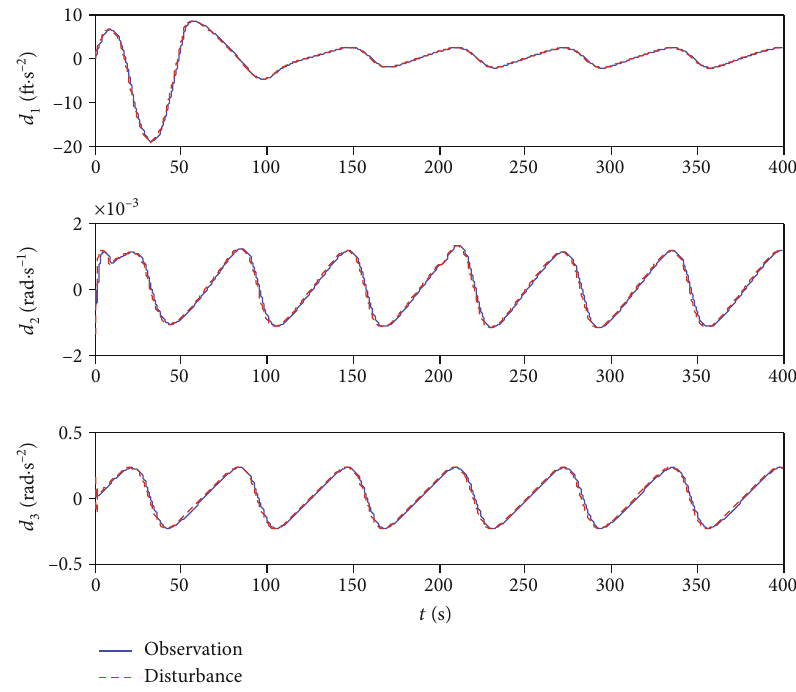
Figure 13: Curves of LESO